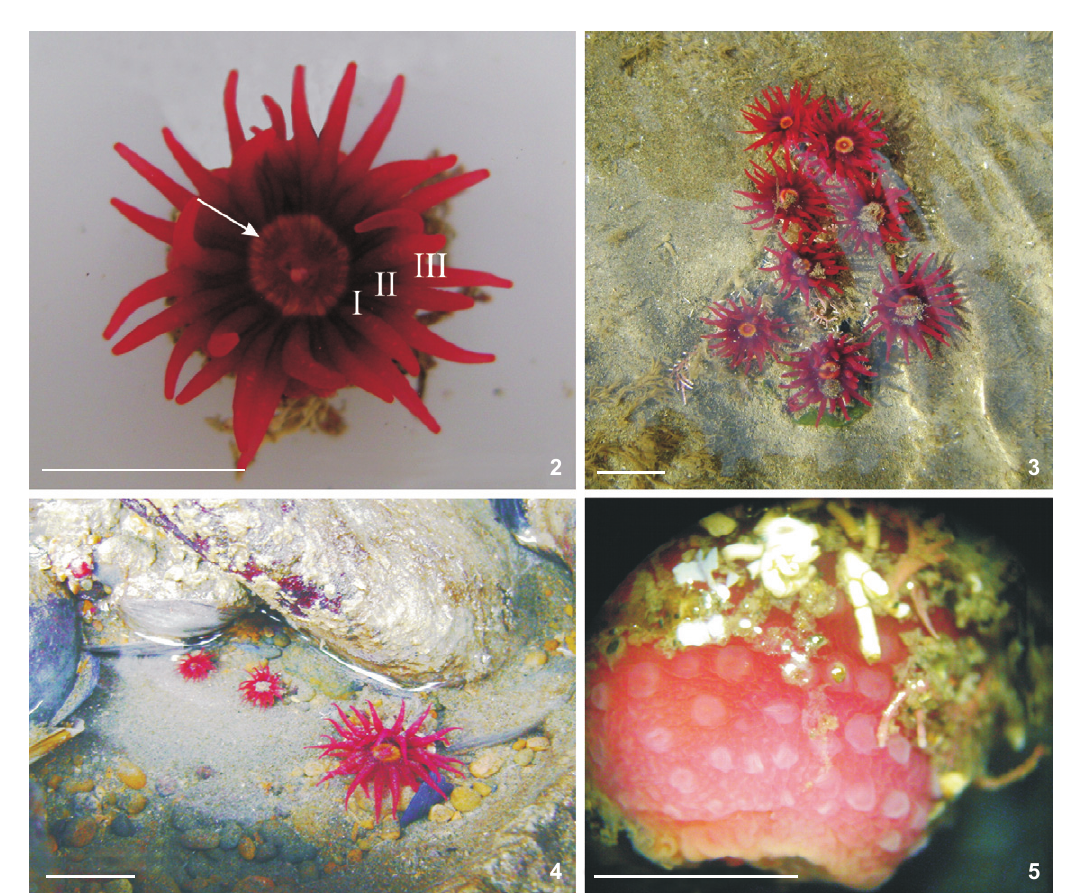
Figures 2-5. Bunodactis octoradiata : (2) oral view (arrow: yellow annulus; I, II and III: 1 st to 3 rd cycle of tentacles); (3) aggregation of individuals in situ; (4) individuals in a tide pool; (5) lateral view of column showing the verrucae and attached material. Scale bars: 10